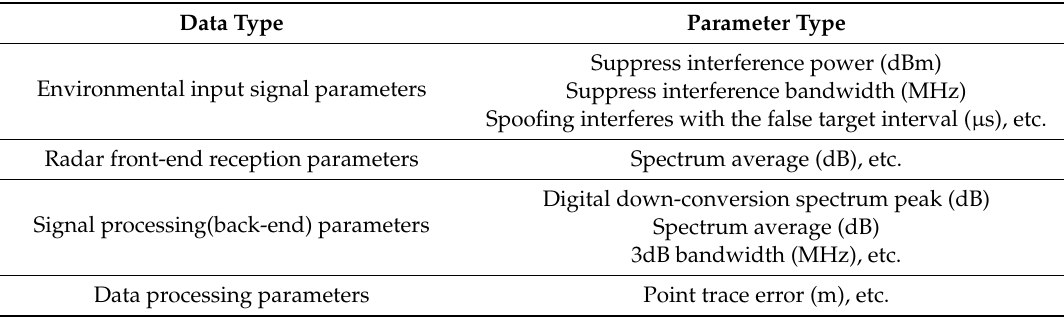
Table 4. Some parameters of radar effect mechanism data.